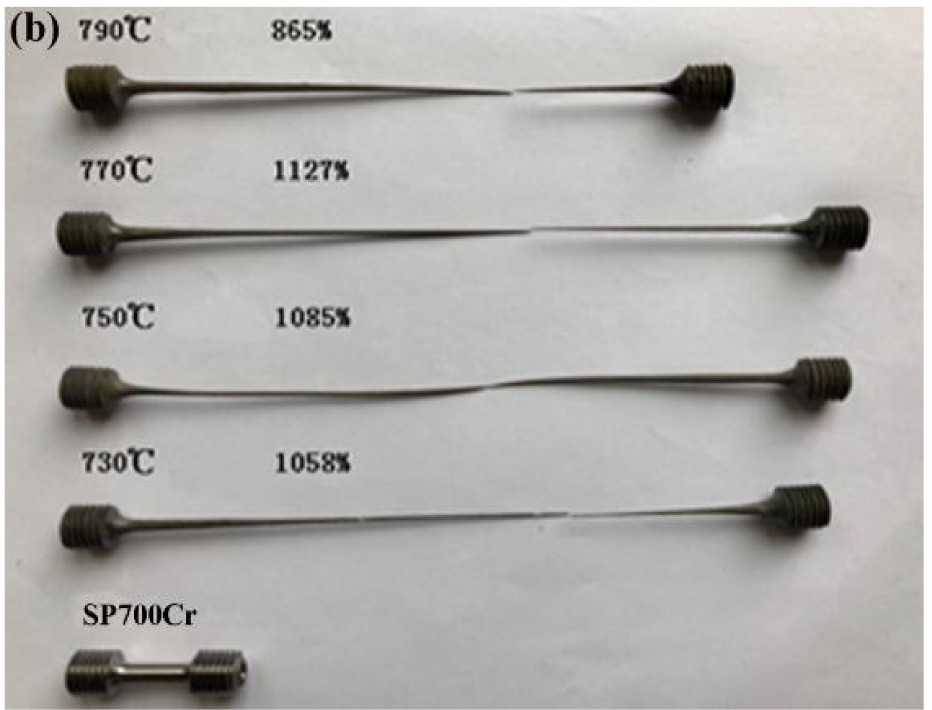
Figure 5. Images of the forged ( a ) SP700 [14] and ( b ) SP700Cr alloys before and after fracture at different tensile